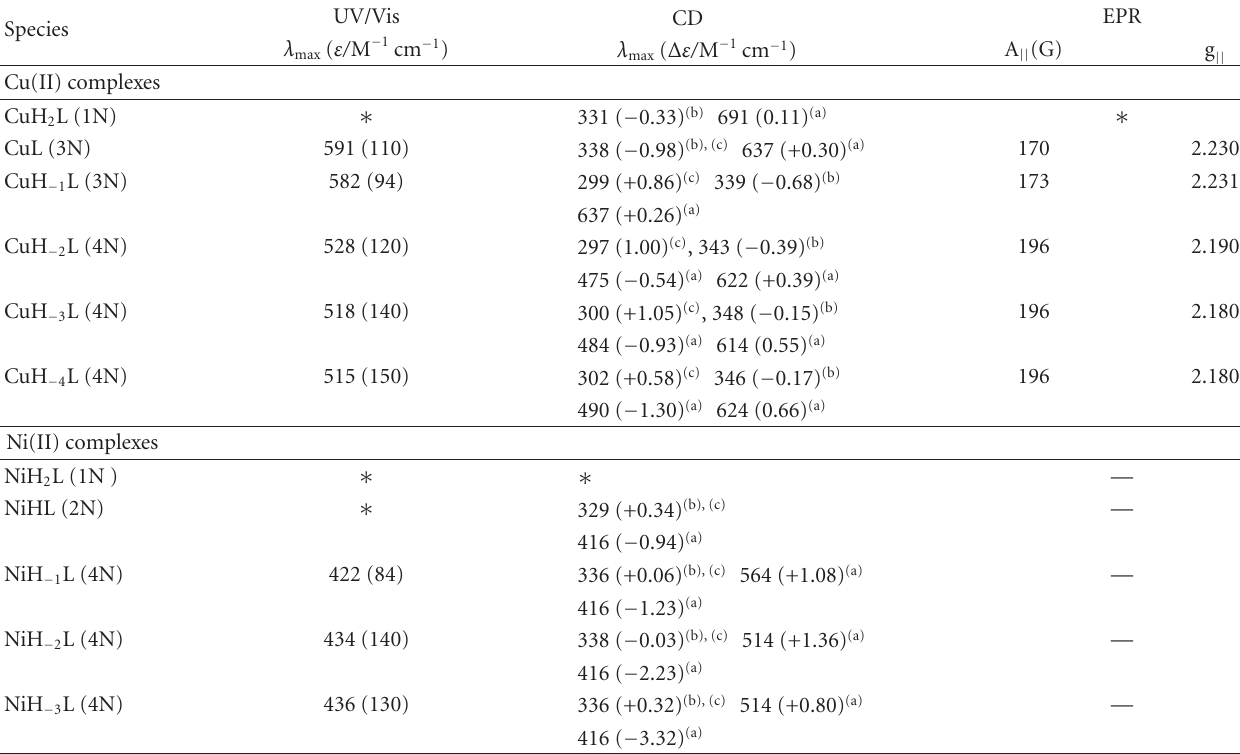
Table 4: Spectroscopic parameters of Cu(II) and Ni(II) complexes of